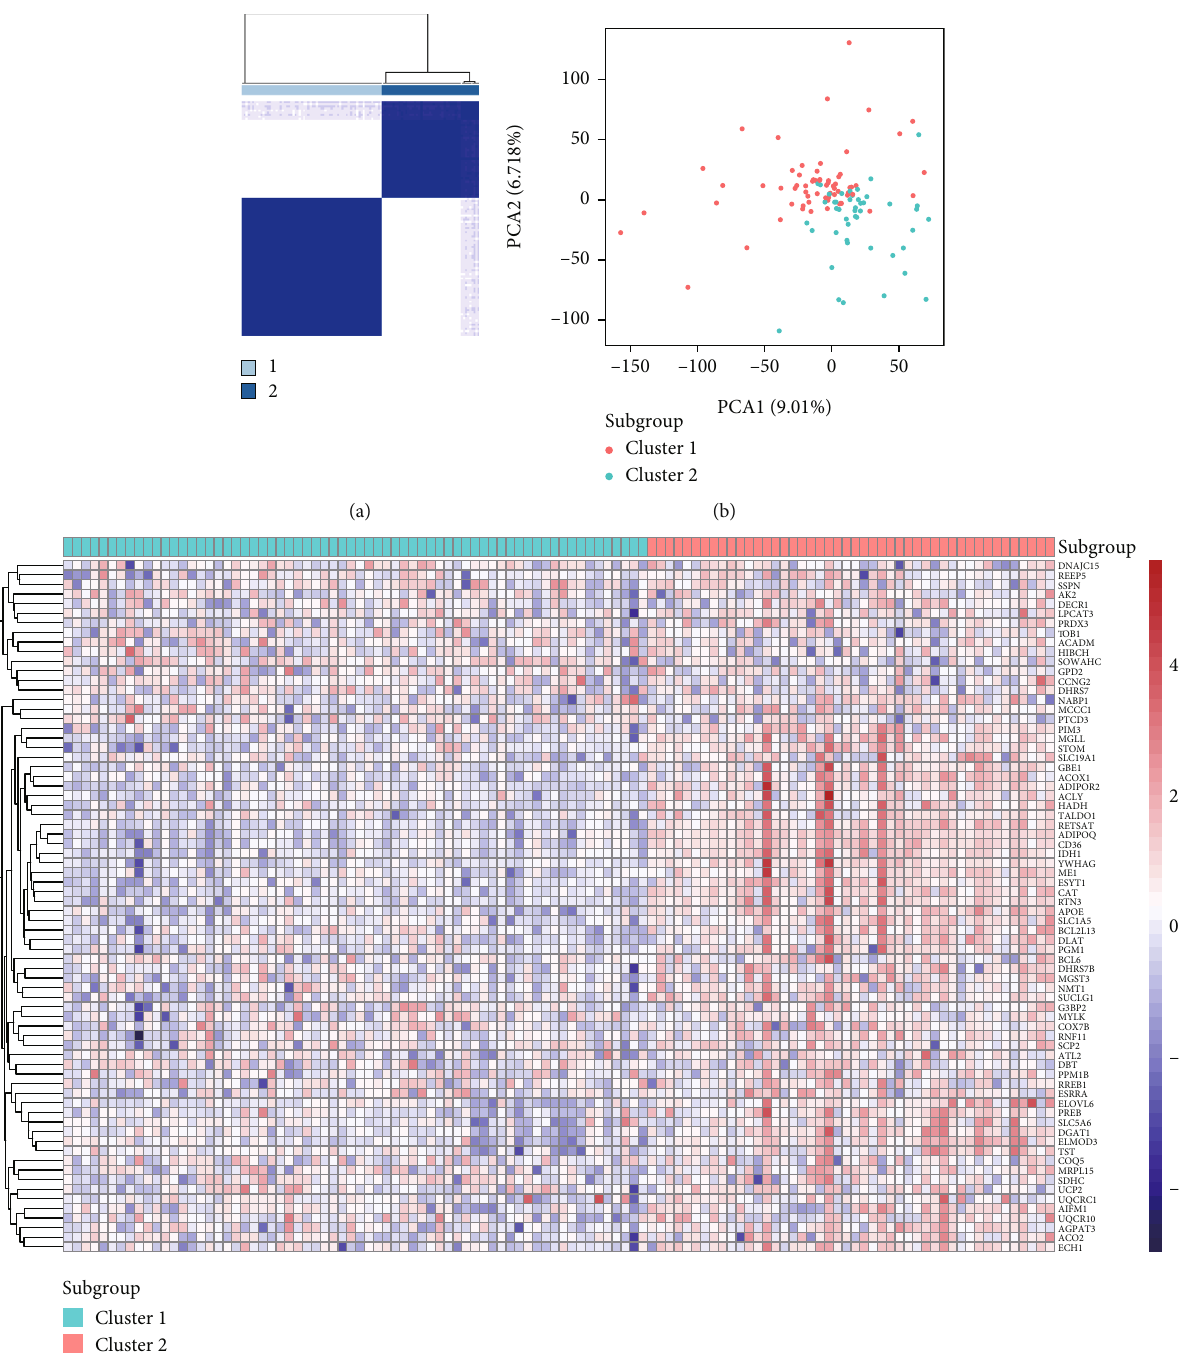
Figure 2: Identi fi cation of adipogenesis subgroups in DPN. (a) Consensus matrix heat map de fi ning two clusters ( k = 2 ) and their correlation area. (b) PCA analysis indicating an obvious di ff erence in transcriptomes between the two subgroups. (c) Di ff erences in expression levels of DEARGs between the two distinct